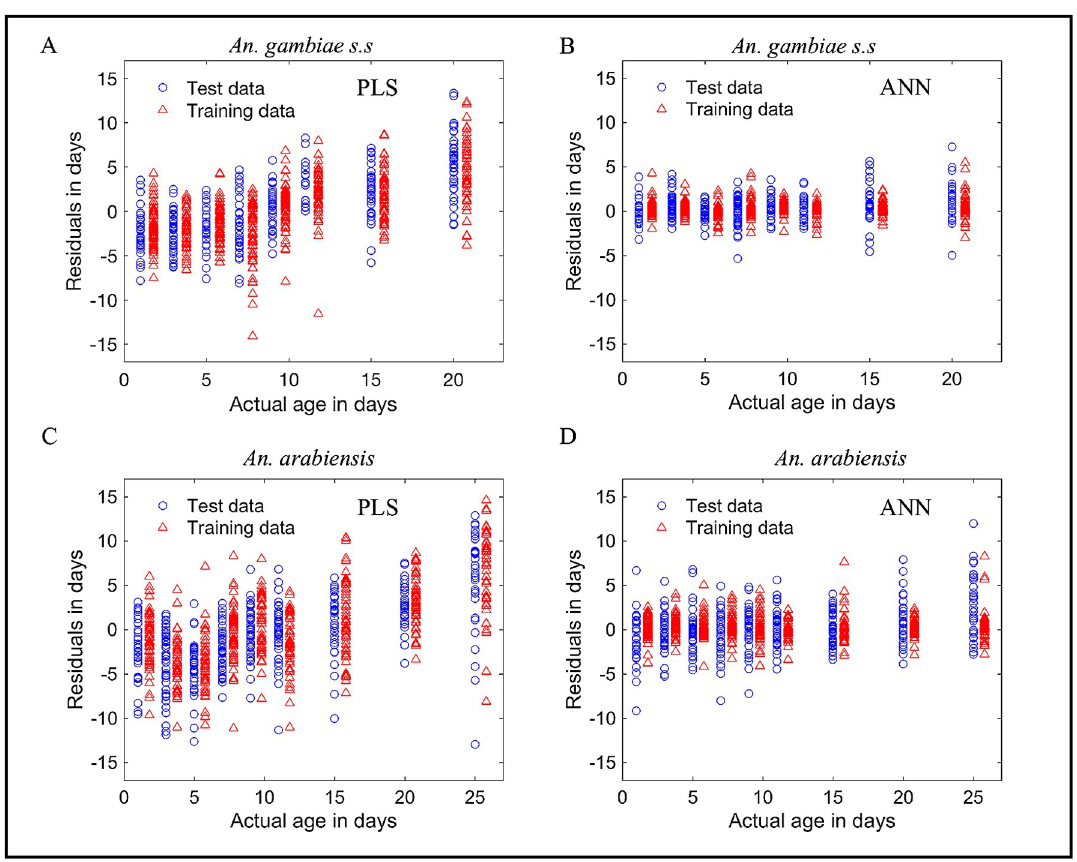
Fig 5. Error distribution per actual age of An . gambiae and An . arabiensis when ANN and PLS regressors applied to estimate the actual ages of mosquitoes in training and test data sets, showing a uniform distribution of errors (un-biased estimating) across actual ages of mosquitoes for the ANN regressor and an un-uniform distribution of errors (biased estimating) for the PLS regressor.